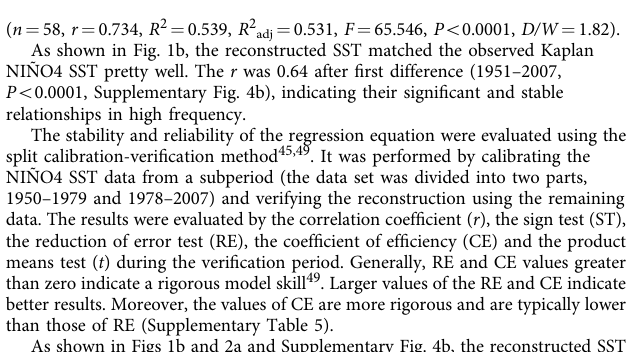
NIN˜O4 SST pretty well. The r was 0.64 after first difference (1951–2007, P o 0.0001, Supplementary Fig. 4b), indicating their significant and stable relationships in high frequency. The stability and reliability of the regression equation were evaluated using the split calibration-verification method 45,49 . It was performed by calibrating the NIN ˜ O4 SST data from a subperiod (the data set was divided into two parts, 1950–1979 and 1978–2007) and verifying the reconstruction using the remaining data. The results were evaluated by the correlation coefficient ( r ), the sign test (ST), the reduction of error test (RE), the coefficient of efficiency (CE) and the product means test ( t ) during the verification period. Generally, RE and CE values greater than zero indicate a rigorous model skill 49 . Larger values of the RE and CE indicate better results. Moreover, the values of CE are more rigorous and are typically lower than those of RE (Supplementary Table 5). As shown in Figs 1b and 2a and Supplementary Fig. 4b, the reconstructed SST matched the observed Kaplan